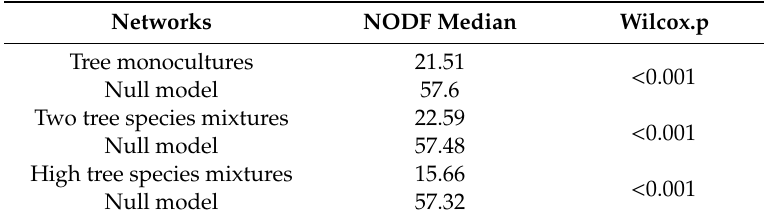
< 0.001 1 Network connectance: Realized proportion of possible links, 2 Fungal generality: Mean e ff ective number of tree species per fungal species, 3 Fungal C score: Average degree of co-occurrence for all possible pairs of fungal OTUs. Values close to 1 indicate evidence for disaggregation, e.g., through competition. Values close to 0 indicate aggregation of species (i.e., no repelling forces between species), 4 Mean number of shared fungal partners: Mean number of fungal species that interact with at least two tree species Table 2. Median nestedness (NODF) values for three tree diversity levels (monocultures, two tree species mixtures, and high tree diversity mixtures) based on null models and bipartite networks generated for 576 subsamples. Networks were generated using a tree species-fungal OTU co-occurrence threshold of 3 /